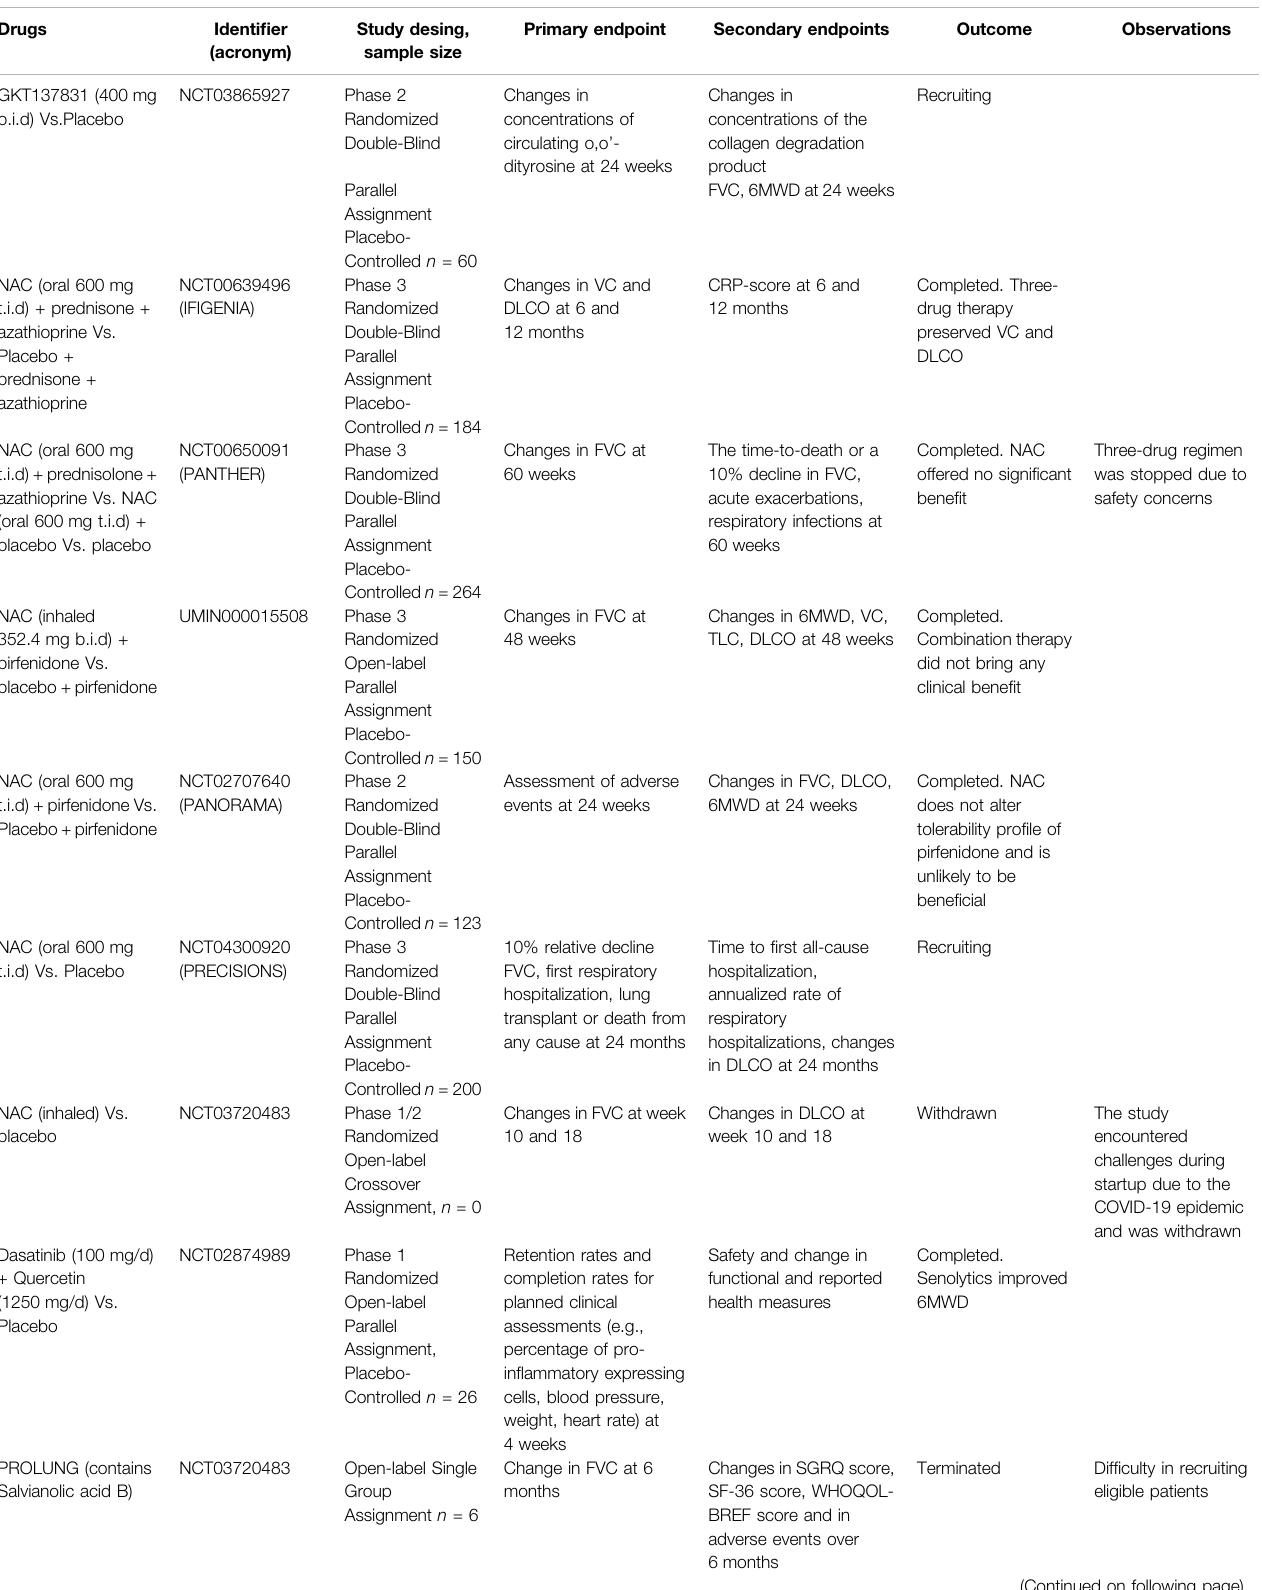
TABLE 4 | Summary of clinical trials of antioxidant therapies of